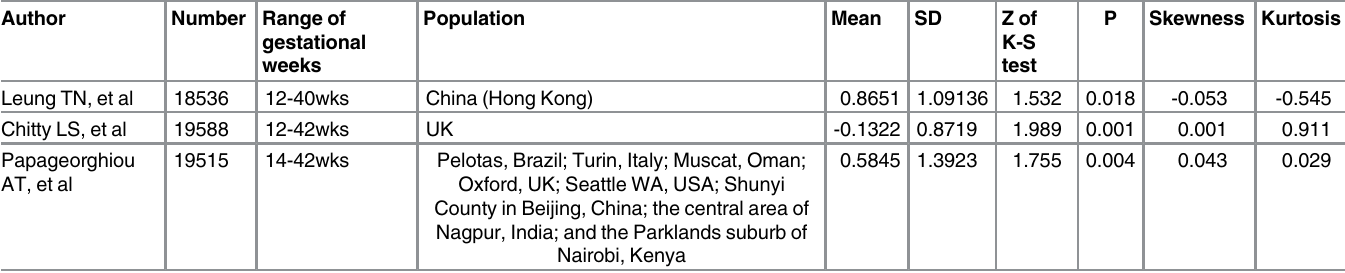
Table 4. Mean, standard deviation (SD) and the results of the Kolmogorov-Smirnov test of